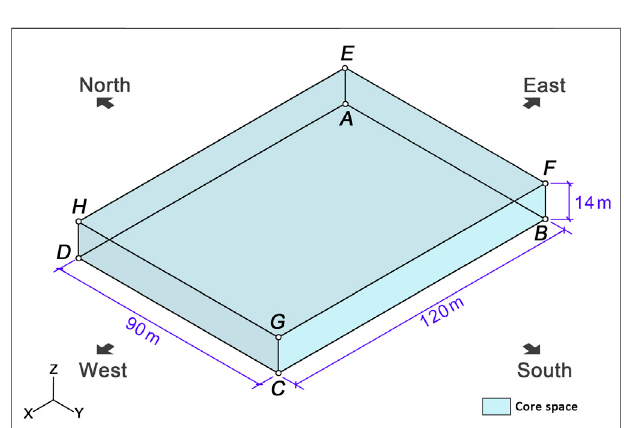
FIGURE 6 | The core space and its variable